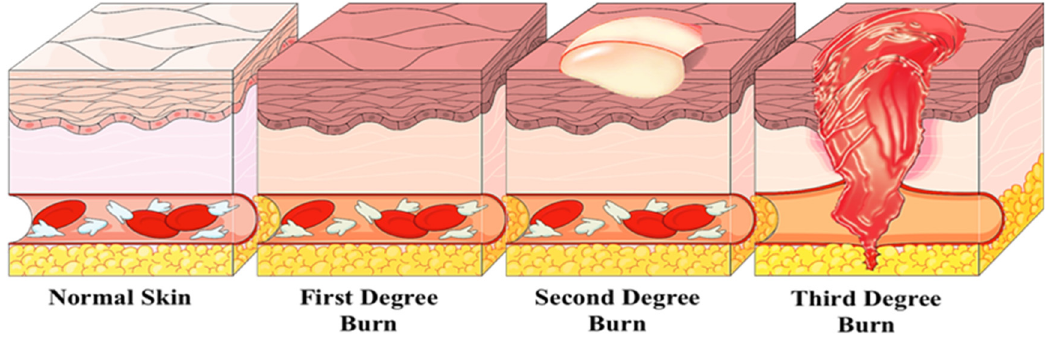
Figure 3. First to third degrees of burn wounds in human